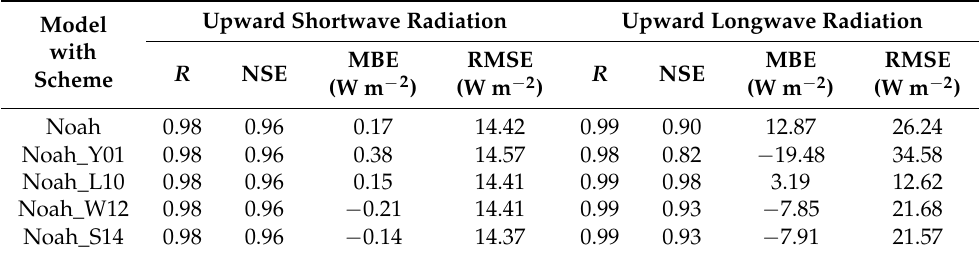
Table 3. Coefficients of correlation (R), model efficiency index (NSE), mean bias error (MBE), and root mean square error (RMSE) between observation and simulation of upward shortwave